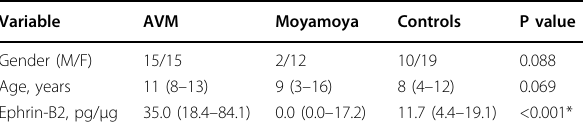
Table 1 Demographics and Ephrin-B2 levels of the study